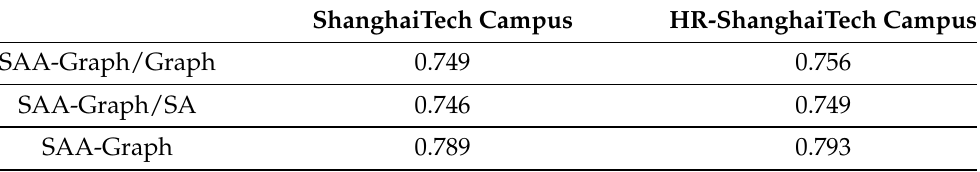
Table 2. Ablation study of SAA-Graph